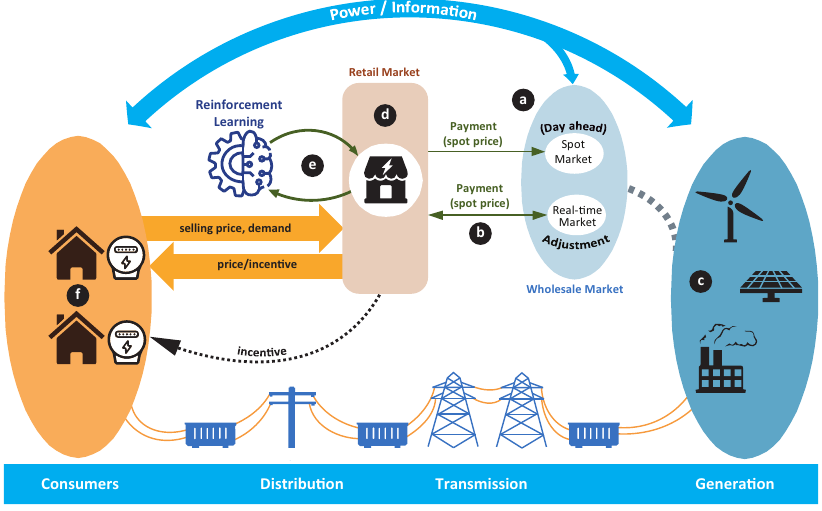
Figure 2. Market